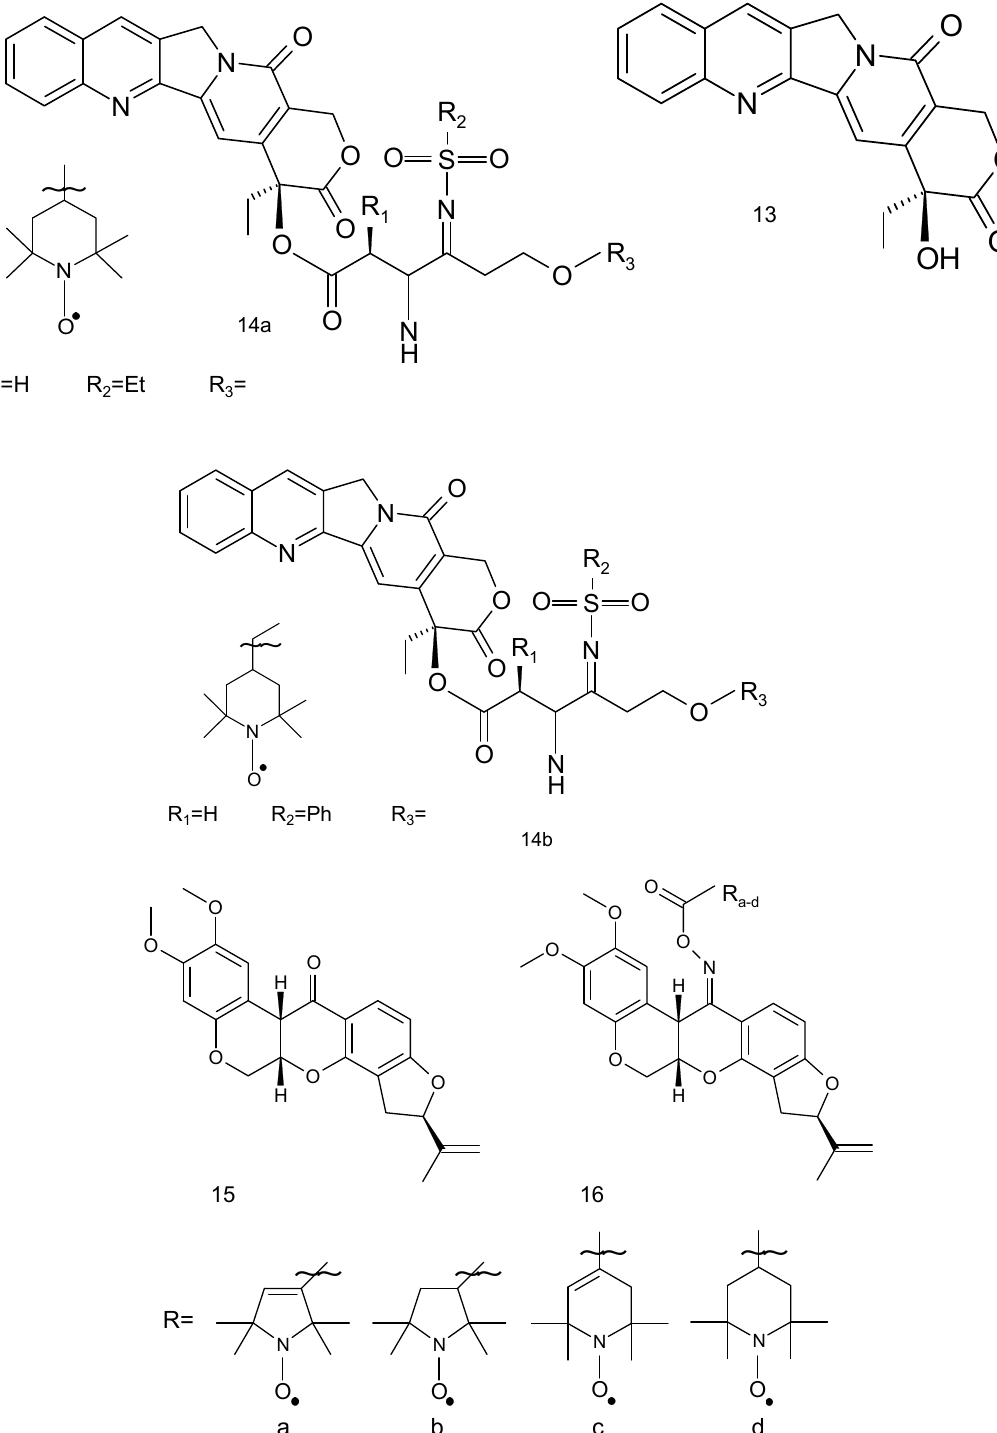
Figure 4. The natural and spin-labelled derivatives used against cancer cell lines: ( 13 ) camptothecin, ( 14 ) spin-labelled camptothecin, ( 15 ) rotenone and ( 16 ) the spin-labelled derivatives of rotenone. The anticancer activity of nitroxides towards HepG2 liver cancer cell line was also demonstrated by Guo et al. (2012) [65] while investigating the imidazoline nitroxide L-NNP ( 17 ) (Figure 5). It was found to be selective for liver cancer cells, while being non-toxic to normal